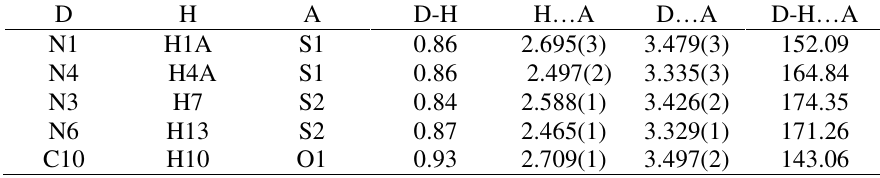
Figure 2. ORTEP structure of the compound (I) , showing 50% probability ellipsoids (H atoms are shown as circles of arbitrary radii.) Table 2. Selected bond distances (Å) for the compound (I)